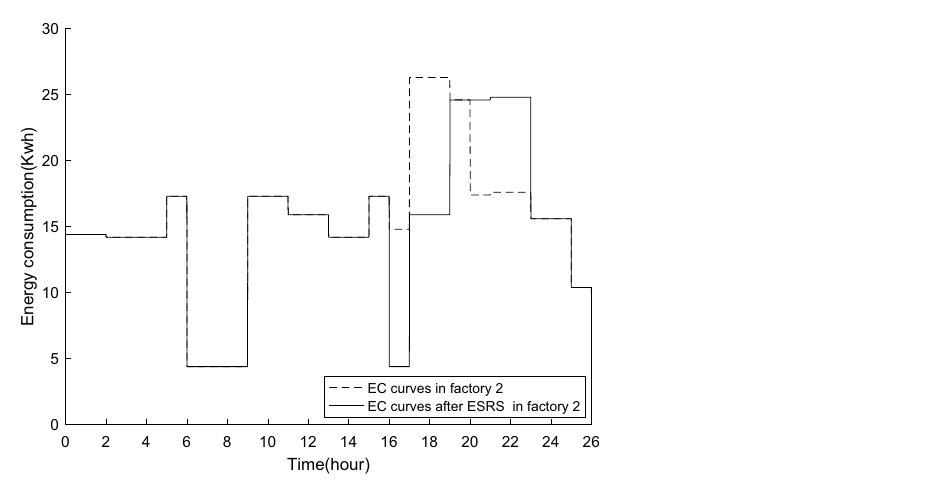
Figure 11. The EC curve in